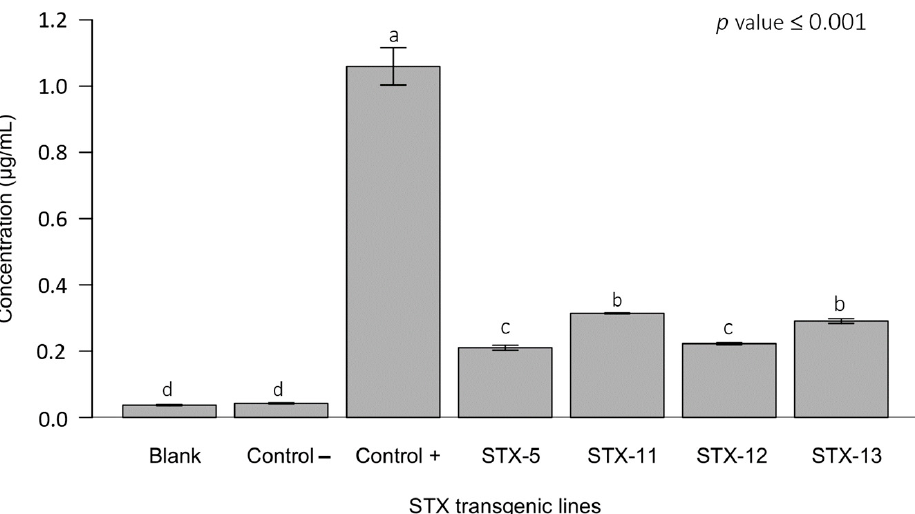
Figure 7. Concentration ( µ g · mL –1 ) of the sarcotoxin IA peptide in the juice of the STX IA transgenic and non-transgenic Pera sweet oranges by the indirect ELISA test. Blank, pre-immune serum; control − , non-transgenic negative control; control +, sarcotoxin IA synthetic peptide 1.0 µ g mL − 1 ; STX-5–STX-13, STX IA transgenic Pera sweet orange lines. Bars followed by the same letter do not differ according to the Tukey´s test ( p ≤ 0.001).